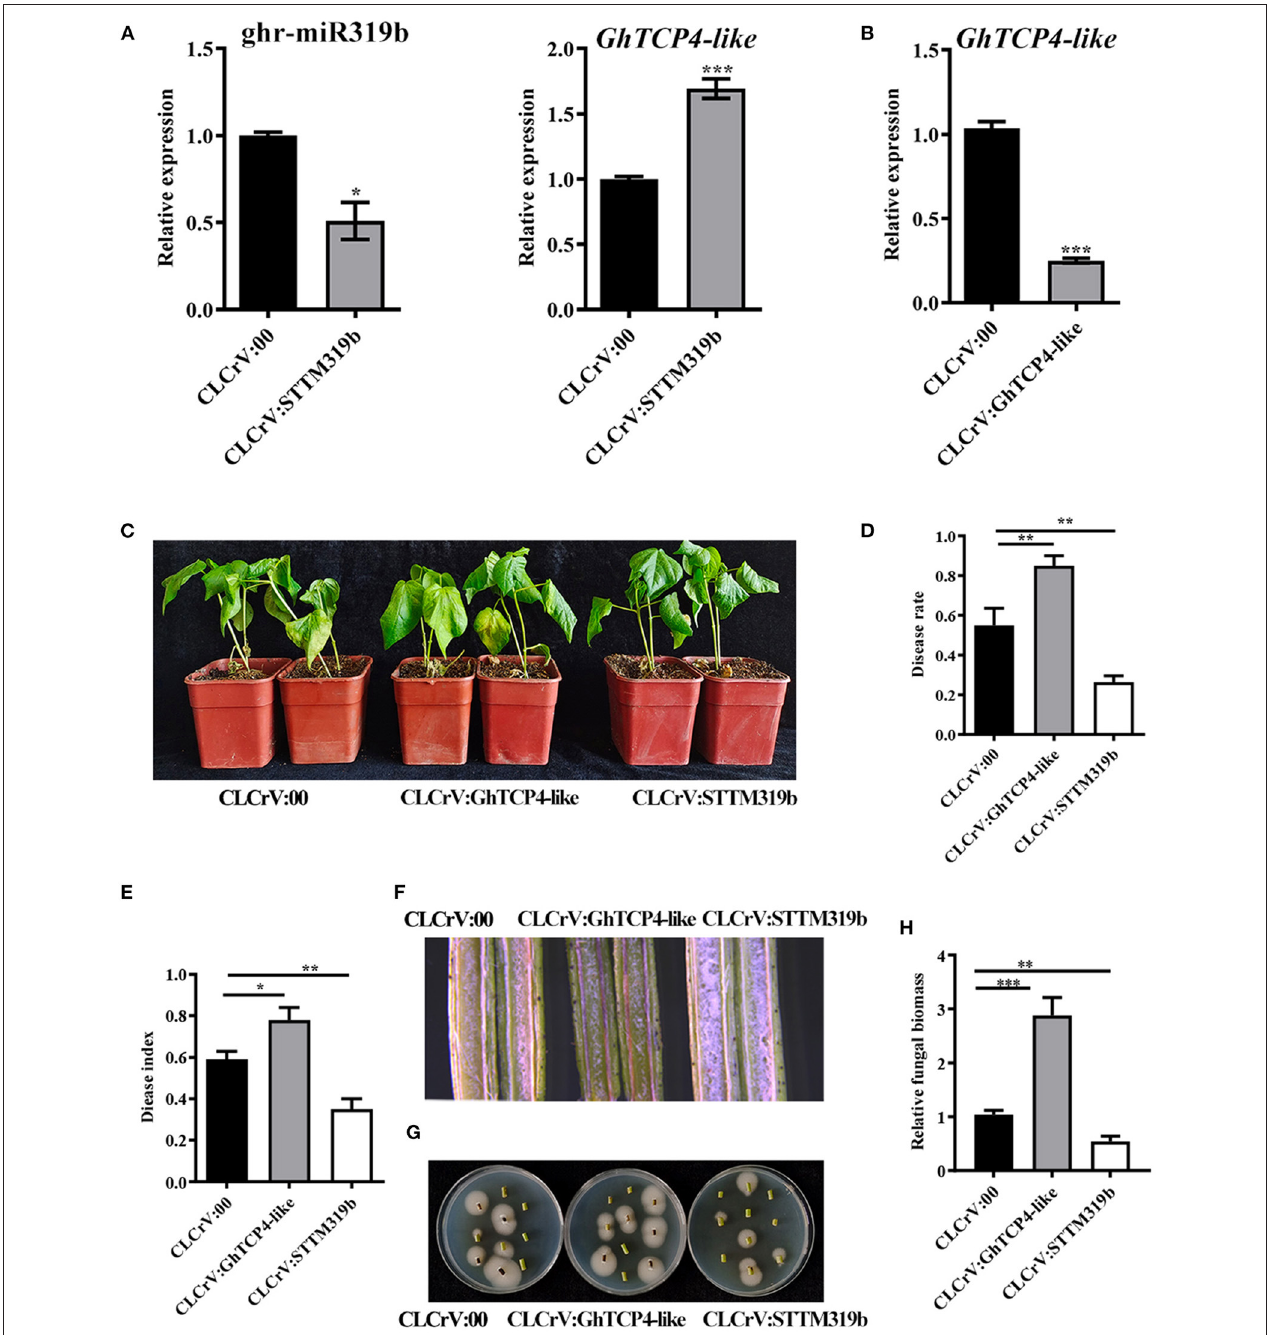
FIGURE 3 | Resistance analysis of ghr-miR319b and GhTCP4-like against V. dahlia . (A) Transcript level of ghr-miR319b and GhTCP4-like in the control and STTM plants determined by qPCR. Total RNA was extracted from the second true leaf 14 d after agroinfiltration. Error bar means SD of three independent